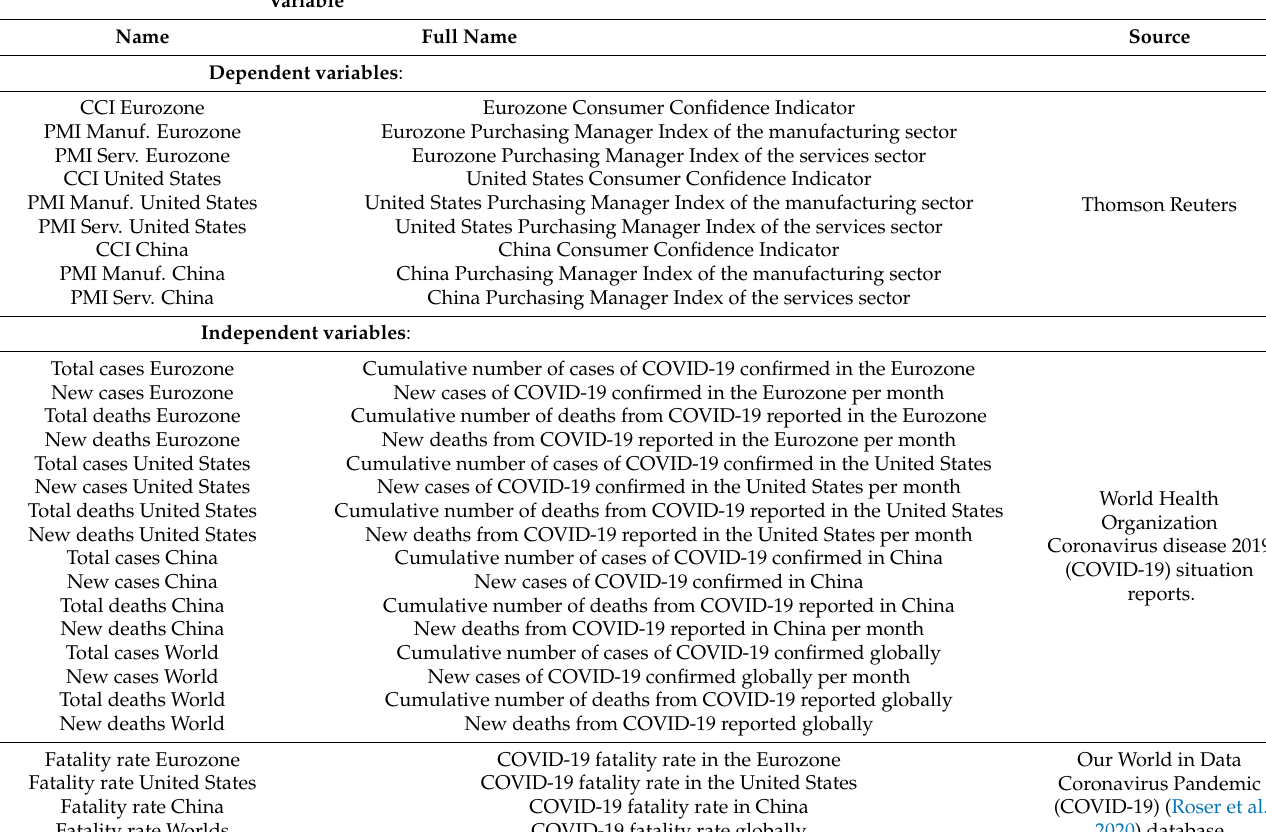
Table 1. Research variables and